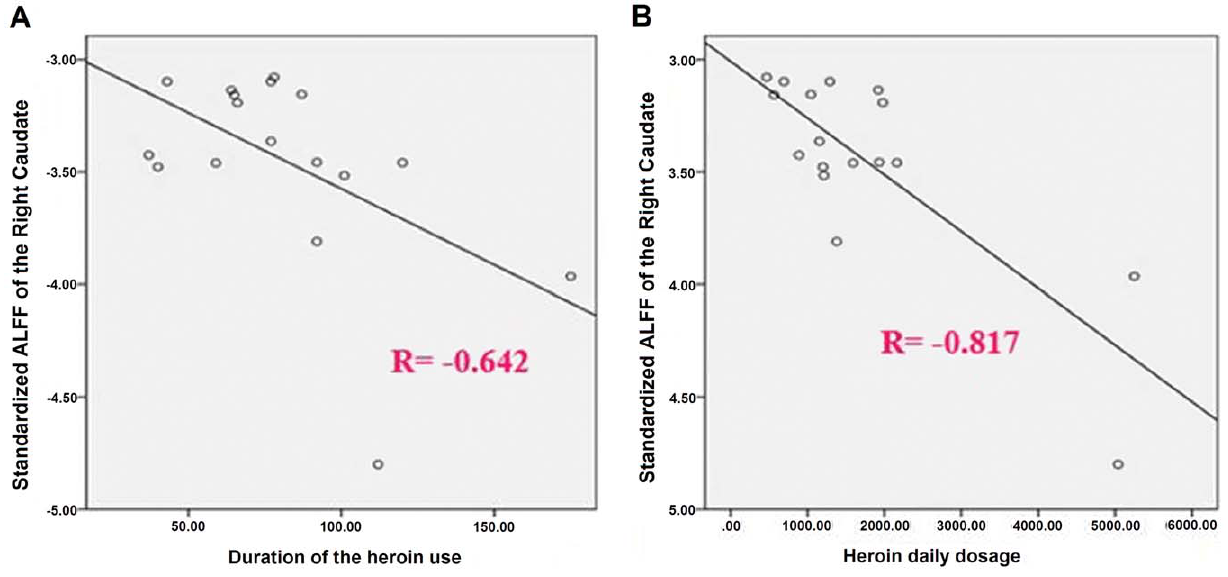
Figure 2. Bivariate scatter plots. A shows the negative correlation between the duration of the heroin use and the standardized ALFF of the right caudate, and B the negative correlation between the heroin daily dosage and the standardized ALFF of the right